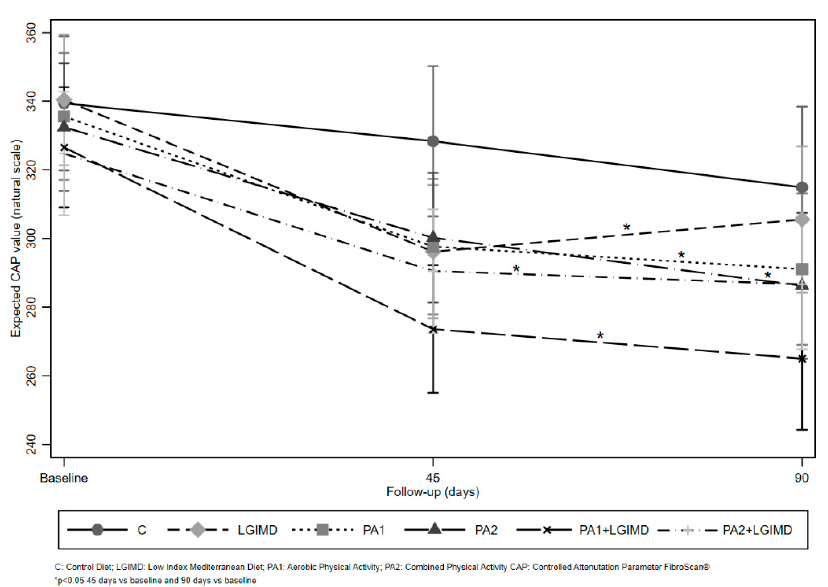
Figure 2. Diet and Physical Activity Effects on NAFLD: Expected CAP values by Treatment and